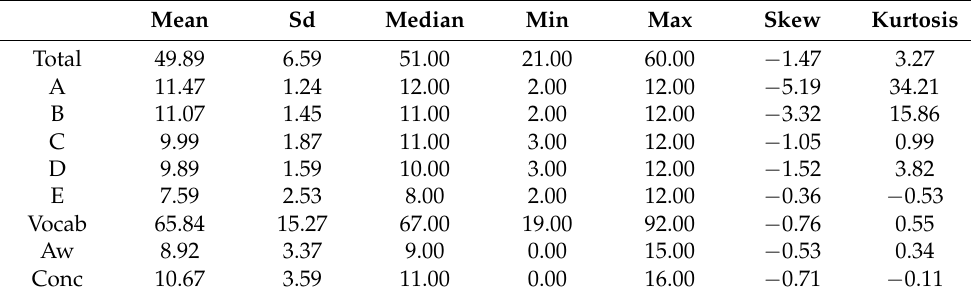
Table 1. Descriptive statistics of cognitive variables.